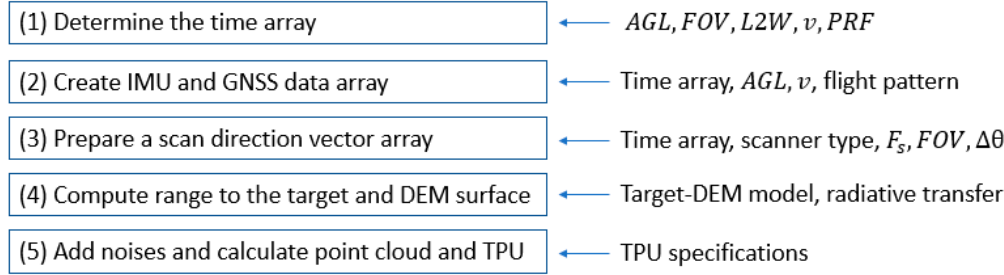
Figure 3. Computation flow of the airborne lidar simulator.